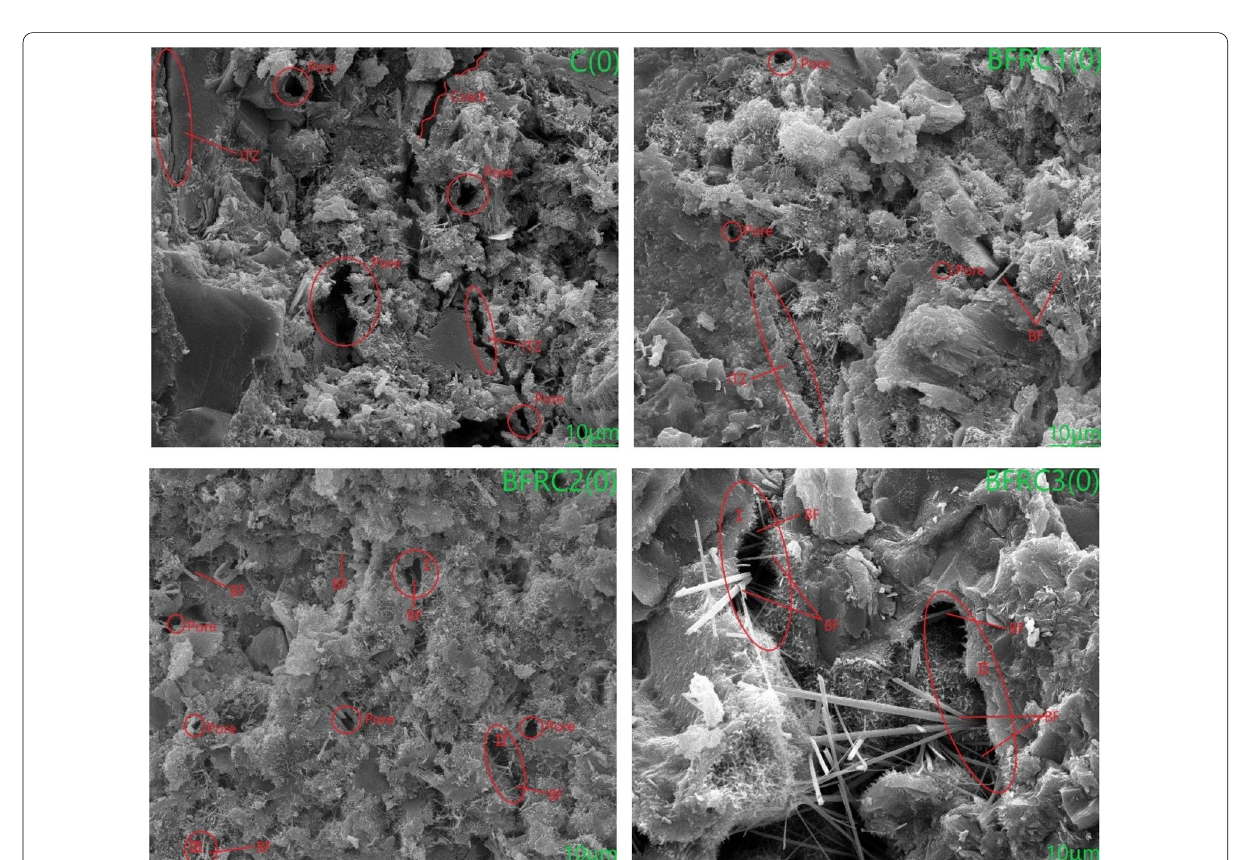
Fig. 8 The SEM of concrete subjected to 28-day standard